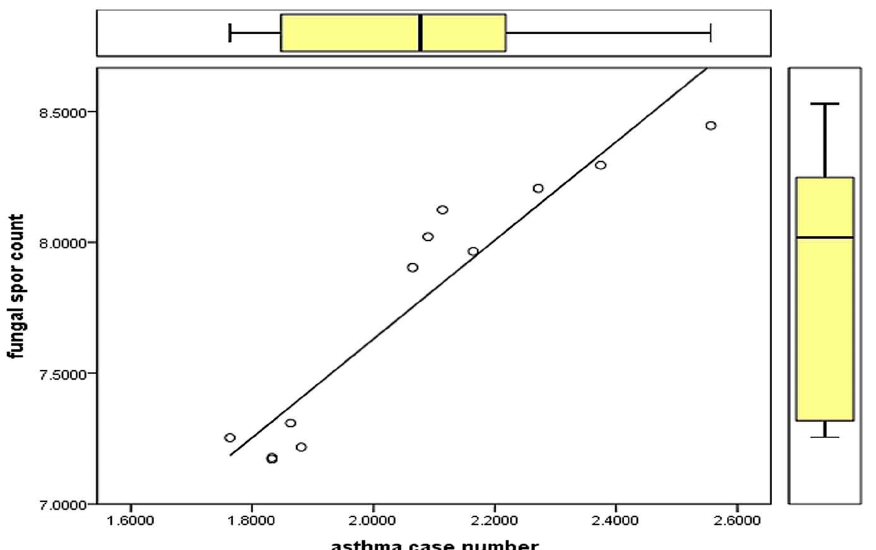
Fig. 3. Simple linear regression between log- fungal spores count in dust and the log- number of patients has